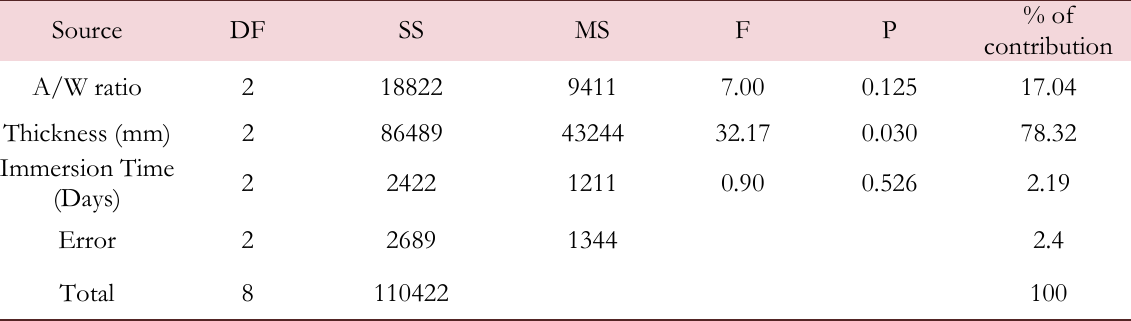
Table 5: ANOVA for load carrying